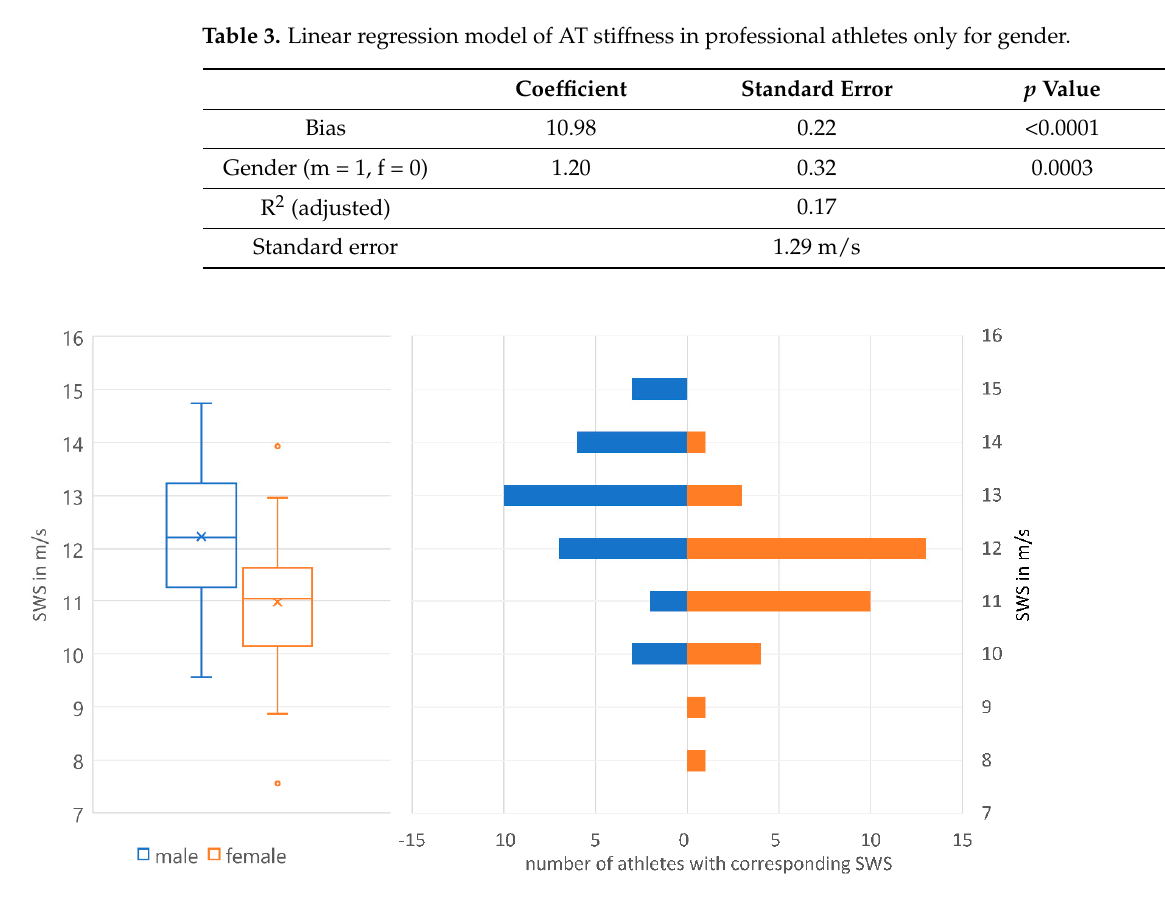
Table 3. Linear regression model of AT sti ff ness in professional athletes only for gender.